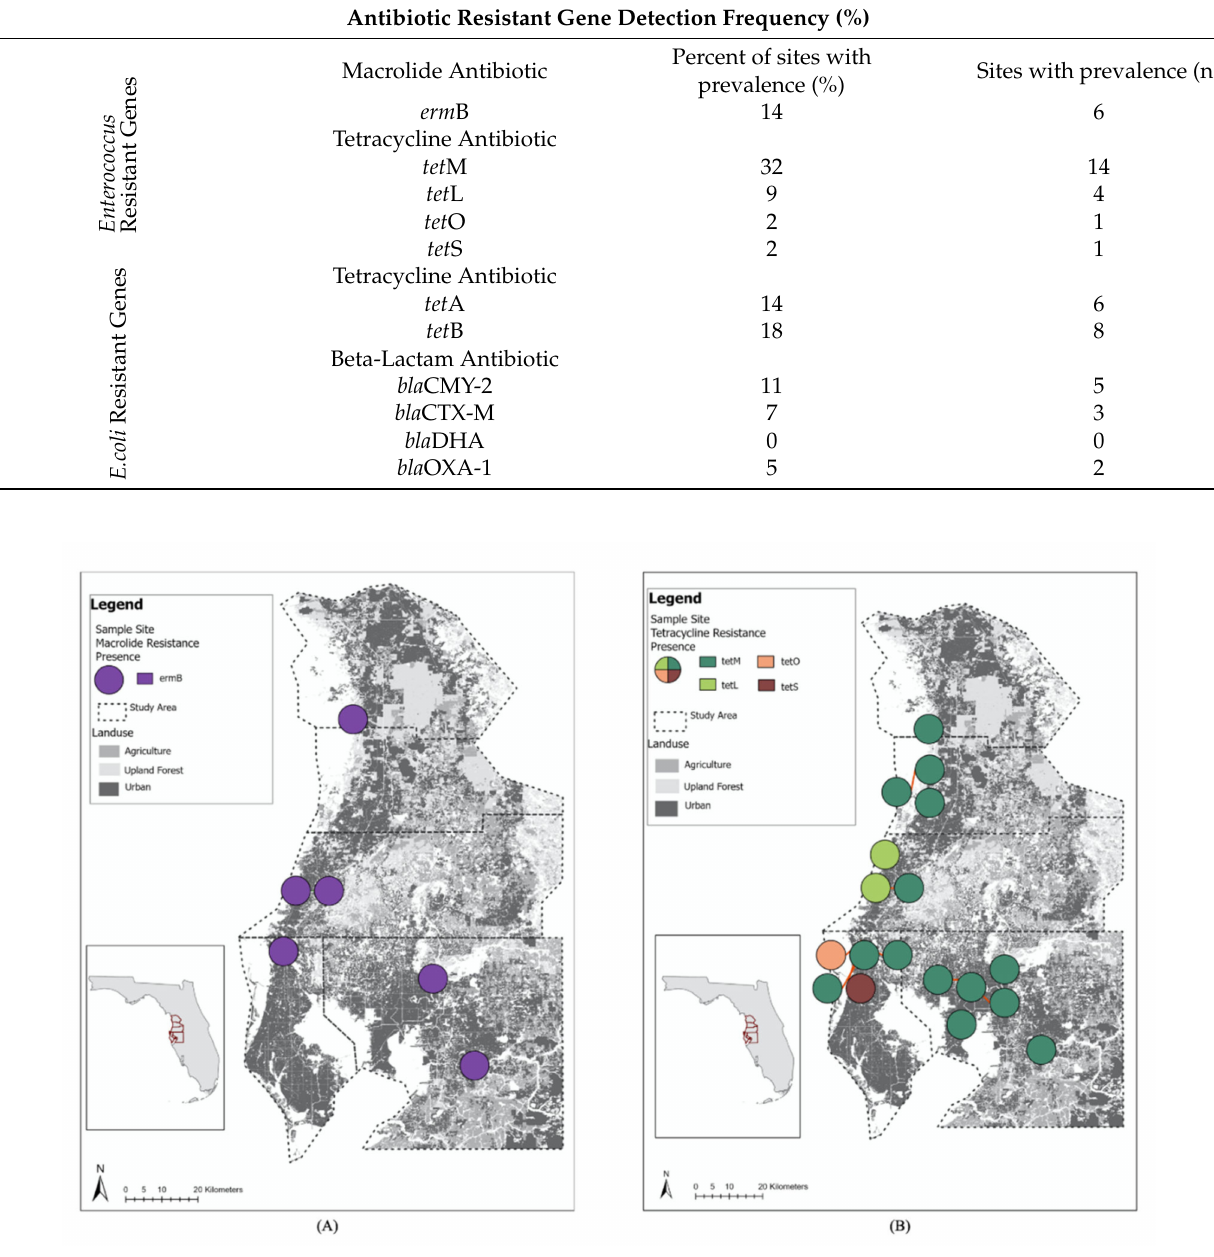
Figure 9. ( A ) Prevalence of macrolide ARGs associated with resistance phenotypes for all Enterococcus spp. in Tampa Bay Metropolitan Area, FL urban karst groundwater. ( B ) Prevalence of tetracycline ARGs associated with resistance phenotypes for all Enterococcus spp. in Tampa Bay Metropolitan Area, FL urban karst